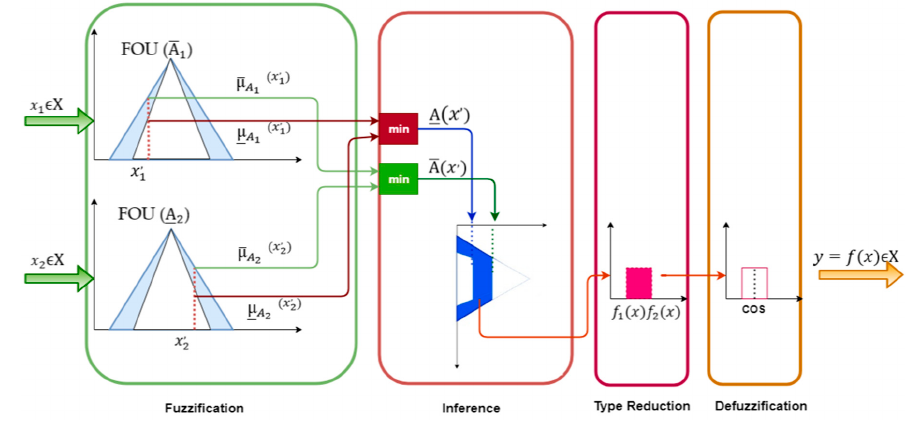
Figure 5. Structure of a type-2 fuzzy logic system.